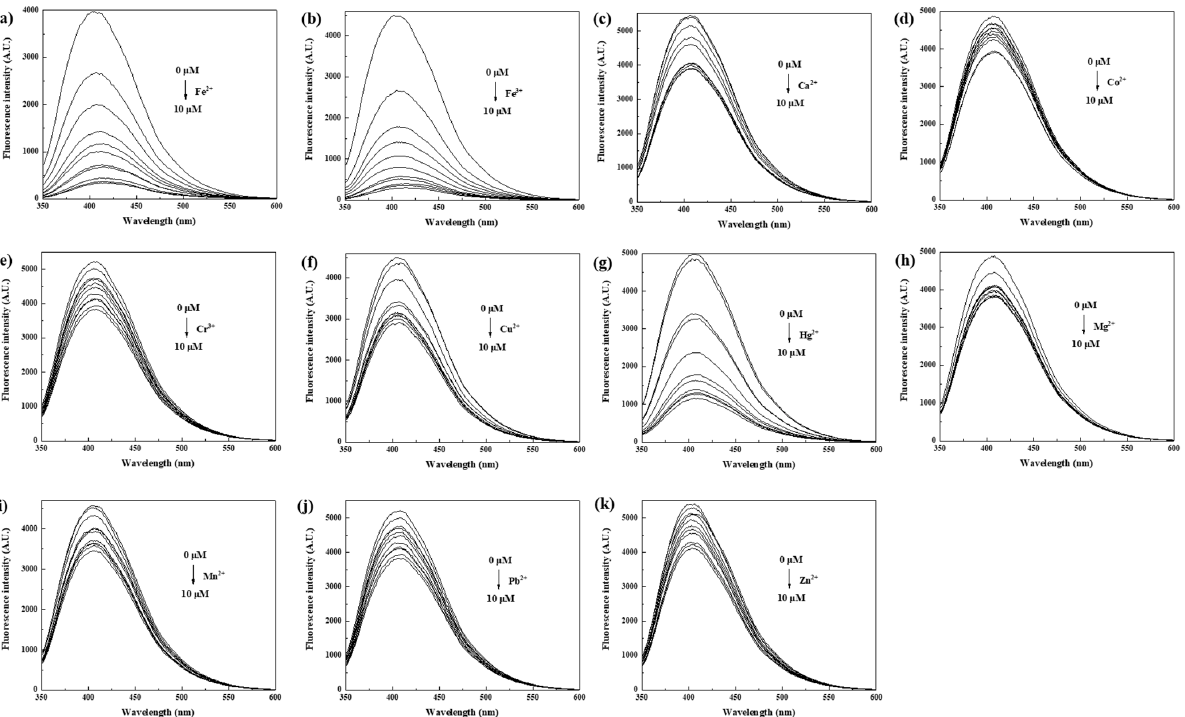
Figure 5. The variation in fluorescence intensity of N, S-PPI-CDs (1 g/L) with the increase in ( a ) Fe 2+ , ( b ) Fe 3+ , ( c ) Ca 2+ , ( d ) Co 2+ , ( e ) Cr 3+ , ( f ) Cu 2+ , ( g ) Hg 2+ , ( h ) Mg 2+ , ( i ) Mn 2+ , ( j ) Pb 2+ and ( k ) Zn 2+ concentration.